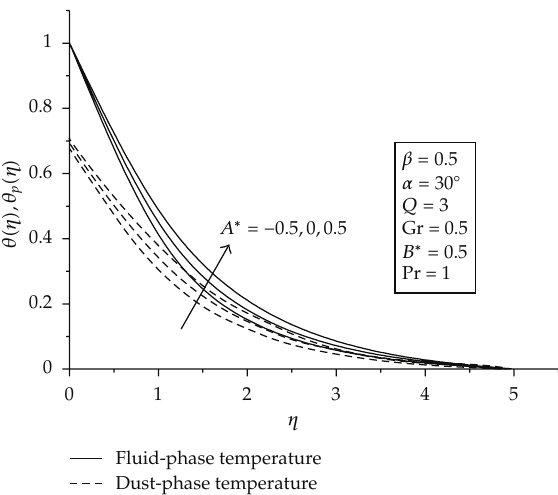
Figure 8: Temperature profile for di ff erent values of space-dependent heat source/sink.